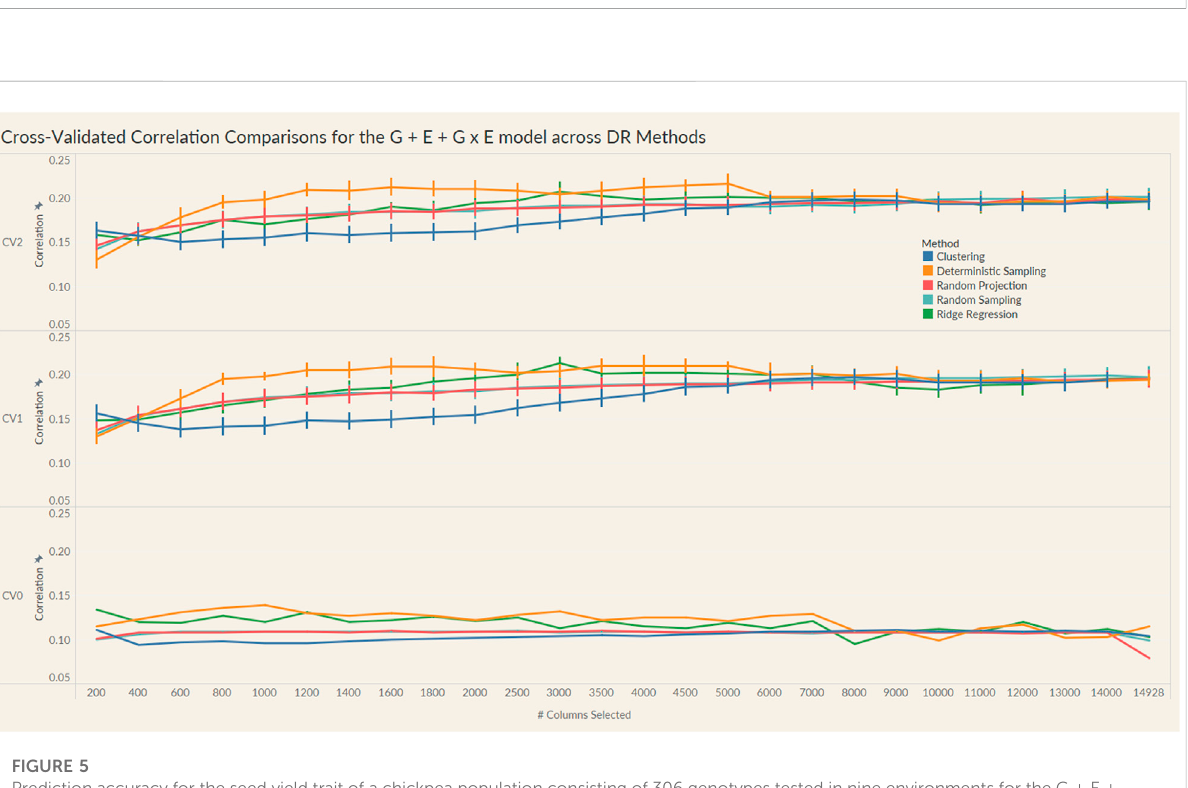
FIGURE 5 Prediction accuracy for the seed yield trait of a chickpea population consisting of 306 genotypes tested in nine environments for the G + E + GxEmodelunderthethreecross-validationschemes(CV0,CV1,CV2)across26differentgenomicinformationsizes.Standarderrorsaredepictedat each